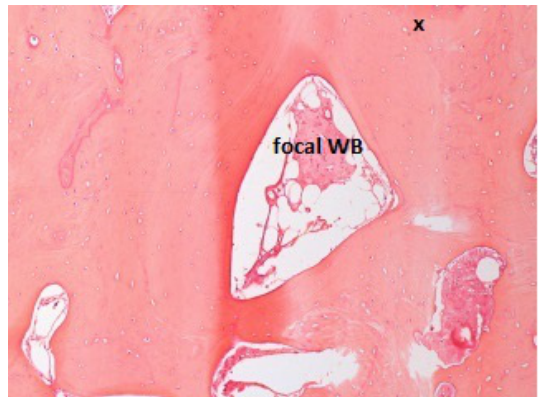
Figure 3. Patient ID: MM. Bone samples taken after 1.5 months of stabilization presented 20% woven bone (WB). The small black cross indicates the apical portion of the sample. While at 2 months, Figure 4 shows 5% woven bone and increased